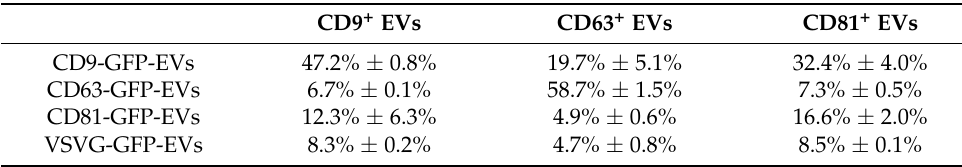
Table 1. Engineering efficiency with different